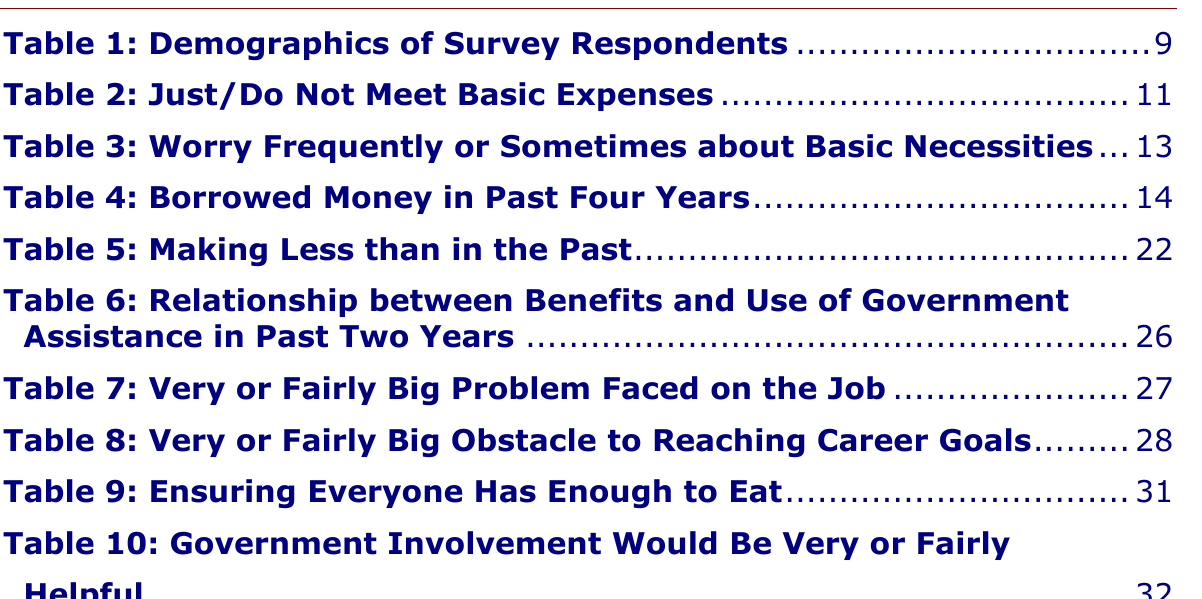
Table 3: Worry Frequently or Sometimes about Basic Necessities ... 13